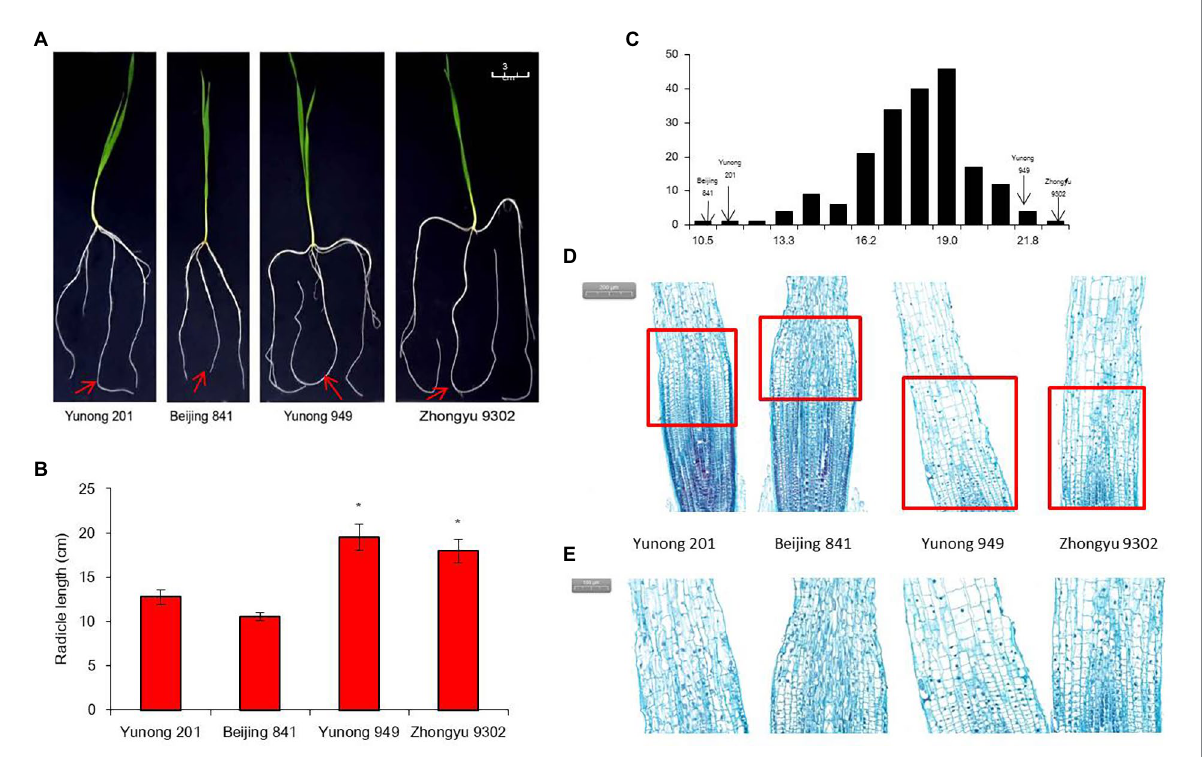
FIGURE 1 Radicle length after 10 days of hydroponic growth in different accessions. (A) Images of the radicle length. Red arrows indicate radicle; (B) Average radicle length difference; (C) Frequency distribution of the radicle length for 196 accessions in the four hydroponic environments; (D) Image of radicle tips in bright field microscopy with stain. Red frames indicate elongation zones; (E) Elongation zone in radicle tip. Significant differences are indicated as p < 0.05 (*).